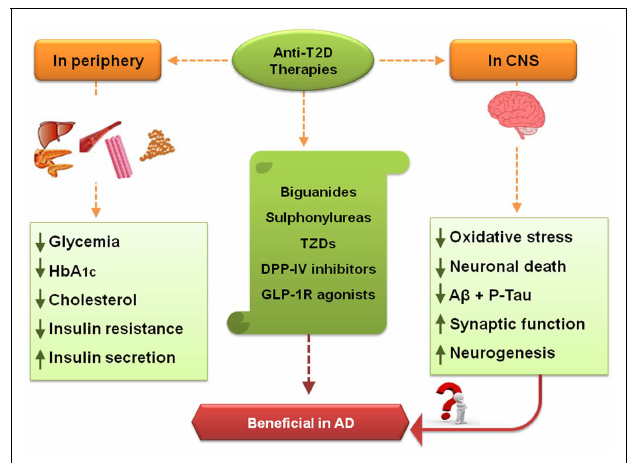
FIGURE 1 | Effects of some anti-T2D therapies – crosstalk between peripheral system and CNS . Some of the treatments directed againstT2D include biguanides, sulfonylureas (SUs), thiazolidinediones (TZDs), and the more recent incretin-based therapies, dipeptidyl peptidase-IV (DPP-IV) inhibitors and glucagon-like peptide-1 receptor (GLP-1R) agonists. InT2D patients, a few treatment goals include decrease of hyperglycemia (a typical feature ofT2D), glycated hemoglobin (HbA 1C ), and total cholesterol levels. Another objective is the decrement in insulin resistance and increased endogenous insulin secretion, as in bothT2D and AD insulin signaling pathways may be impaired. Some anti-T2D therapies may also positively affect CNS, namely via counteracting oxidative stress, mitochondria dysfunction, and neuronal death, together with the stimulation of neurogenesis and synaptic function.These therapies also decreased amyloid β (A β ) accumulation and hyperphosphorylated tau protein, suggesting that they may be beneficial against